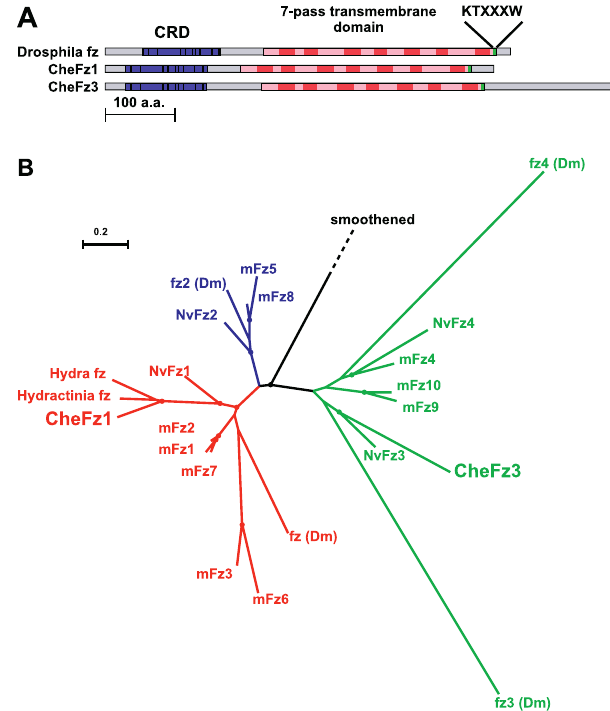
Figure 1. Two Clytia Frizzled Genes Belonging to Distinct Families (A) Domain structure of CheFz1 and CheFz3 proteins compared to the Drosophila Frizzled protein. Blue boxes: cysteine-rich domains; Pink/red boxes: seven-pass transmembrane domains (transmembrane regions in red); green boxes: KTXXXW motif. (B) Maximum likelihood analysis of relationships of Frizzled sequences from mouse (m), Drosophila melanogaster (Dm), and the known cnidarian Frizzleds: Hydra vulgaris, Hydractinia echinata, and N. vectensis (Nv). The tree was rooted using the Drosophila Smoothened sequence. Scale indicates number of inferred substitutions per site.